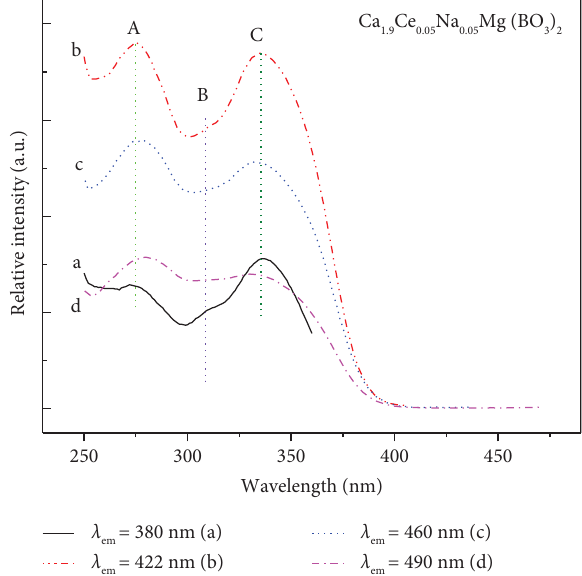
Figure 3: UV excitation spectra of Ca RT.